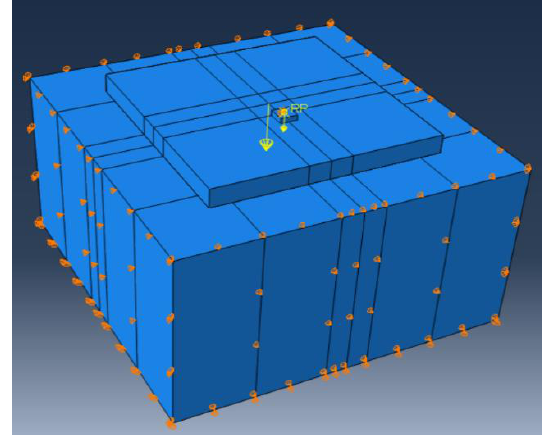
Figure 7. Meshing of the model.